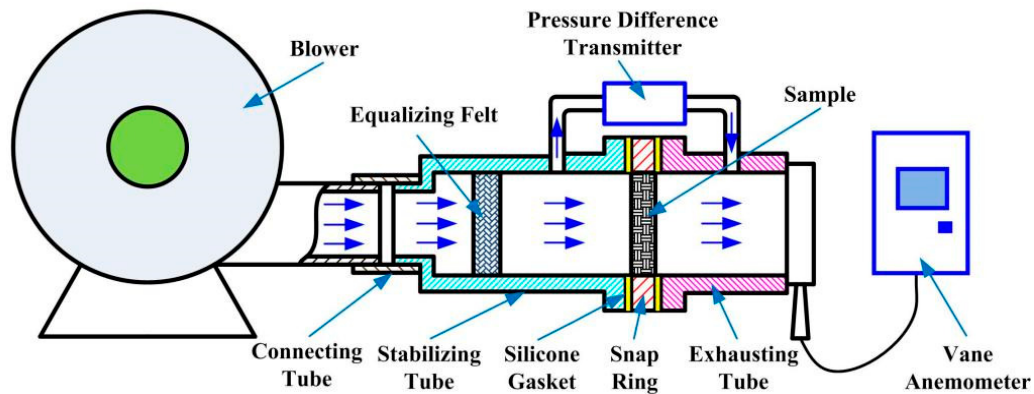
Figure 2. Schematic of the experimental apparatus for measuring the pressure drop across SCSSFFC/Al 2 O 3 .